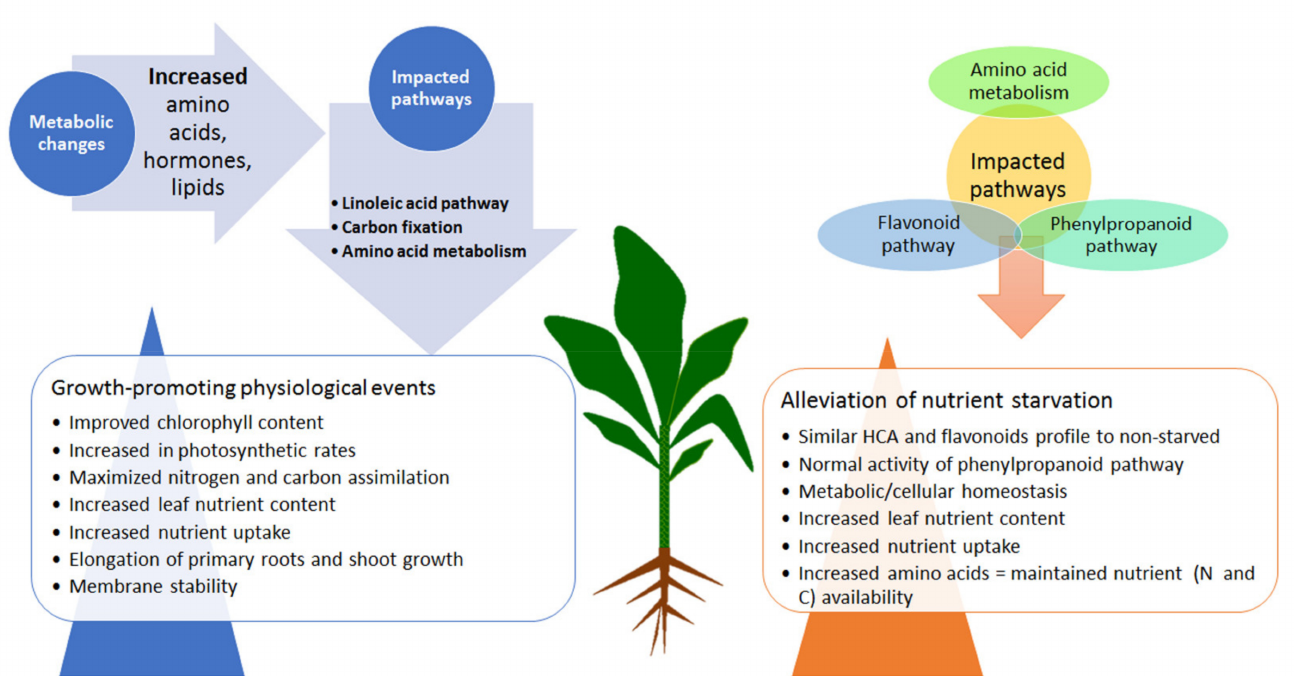
Figure 5. A contextual summary of postulated mechanisms elucidated from this study. The left side of the plant highlights the changes in metabolites involved in the key impacted pathways, leading to growth-promoting physiological events under HS treatment in non-starved conditions. On the right side of the plants are the biochemical alterations in the levels of metabolites spanning the impacted pathways identified in the HS-treated, starved plants, which were associated with the HS-enhanced alleviation of nutrient